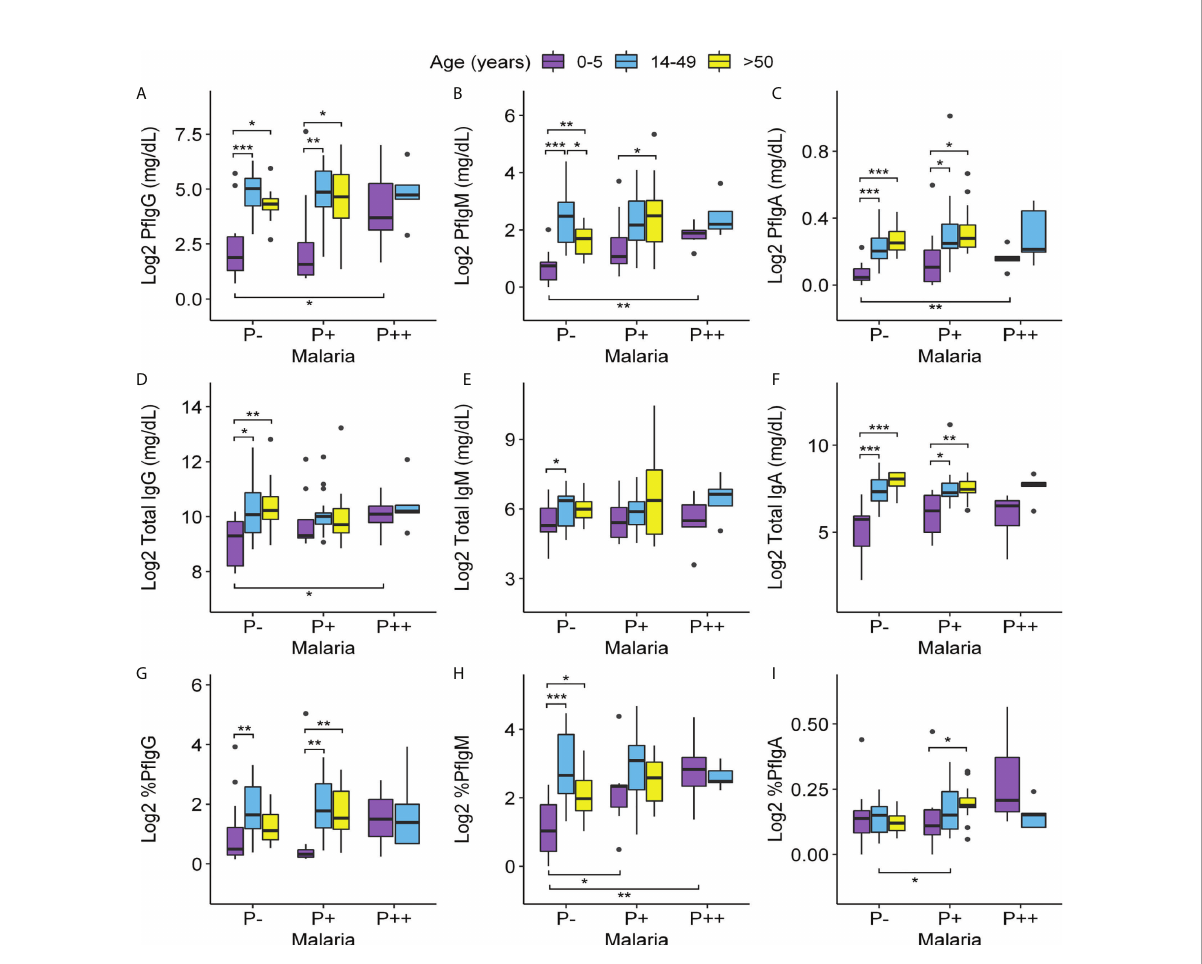
FIGURE 3 Variations of Pf-speci fi c and total IgG, IgM, and IgA levels according to age and parasitemia. Levels of (A – C) : Pf-IgG, Pf-IgM, and Pf-IgA (mg/dl); (D – F) : total IgG, IgM, and IgA (mg/dl); and (G – I) : percentages of Pf-IgG, Pf-IgM, and Pf-IgA out of the total of 91 individuals with age ranges 0 – 5, 14 – 49 non-pregnant, and >50 (eight of the total were discarded because of lack of serum sample or being HIV+). Data were log 2 - transformed with a pseudo-count of 1. P++, microscopic malaria; P+, submicroscopic malaria; P − , uninfected individuals. Each box plot shows a distribution of antibody levels of each group (box hinges indicate the 25th and 75th percentiles, the whiskers extend to hinges ± 1.5 × IQR, and outliers are shown as black points). Signi fi cant differences obtained by unpaired Wilcoxon rank-sum tests are indicated. Signi fi cance between age groups is marked at the top of the graph and signi fi cance between infection groups is marked at the bottom. *P ≤ 0.05; **P ≤ 0.01; ***P ≤